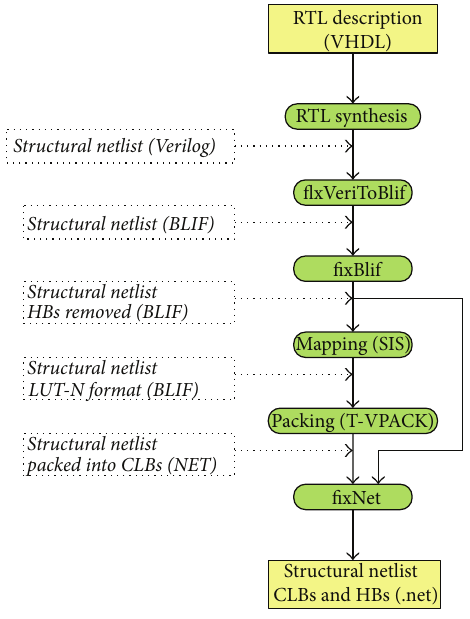
Figure 4: RTL to NET software